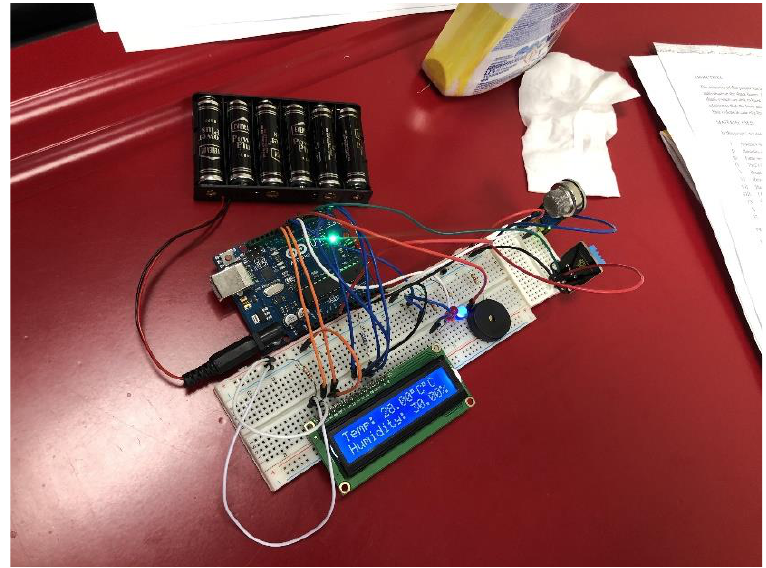
Sensors 2022 , 22 , x FOR PEER REVIEW